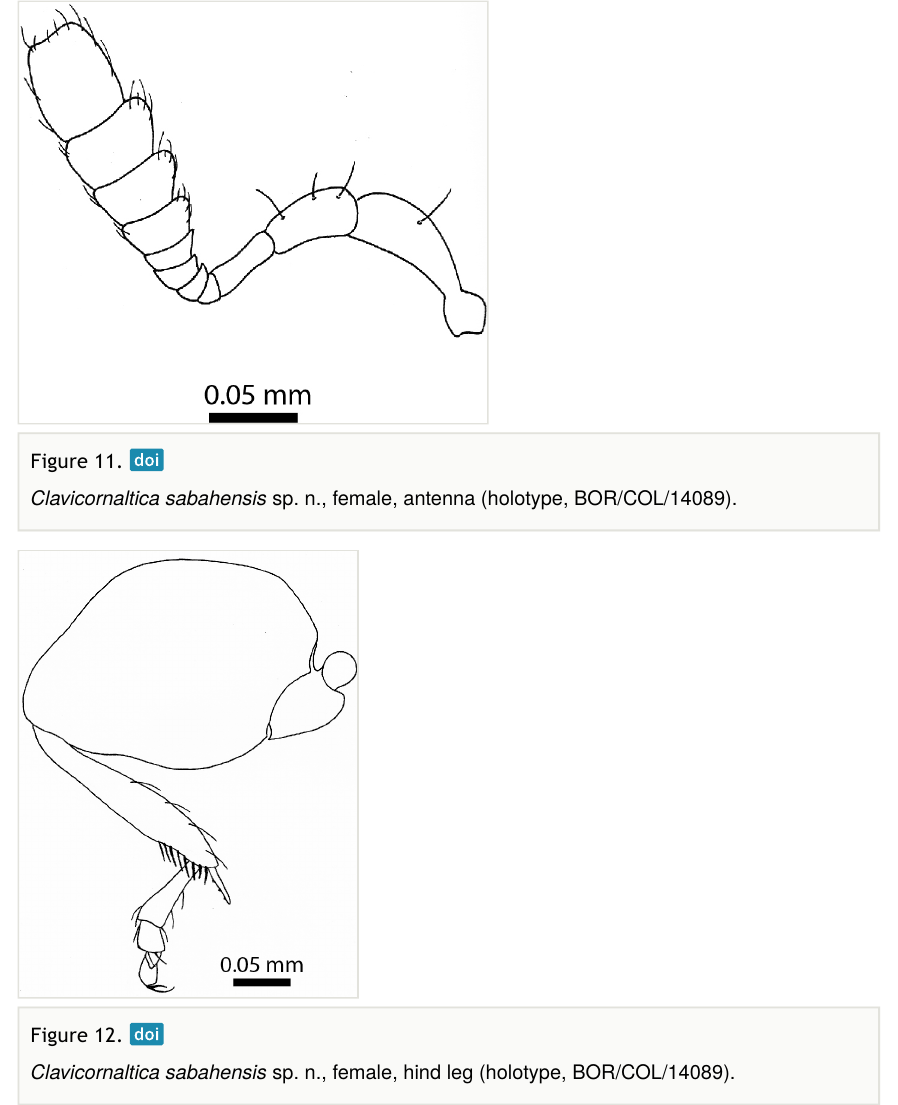
Abdomen : Carina on the fi rst abdominal sternite sharp and narrow. Diagnosis Di ff erential comparisons were made with all known species of the genus. Clavicornaltica sabahensis sp. n. di ff ers from these in the following respects. Clavicornaltica buechei Medvedev, 2008 (Sulawesi): is larger (1.4 mm) and the ridge on the fi rst abdominal segment is widened posteriorly (Medvedev 2008). Clavicornaltica mizusawai Suenaga & Yoshida, 2016 (Taiwan) has impunctate elytra and larger eyes